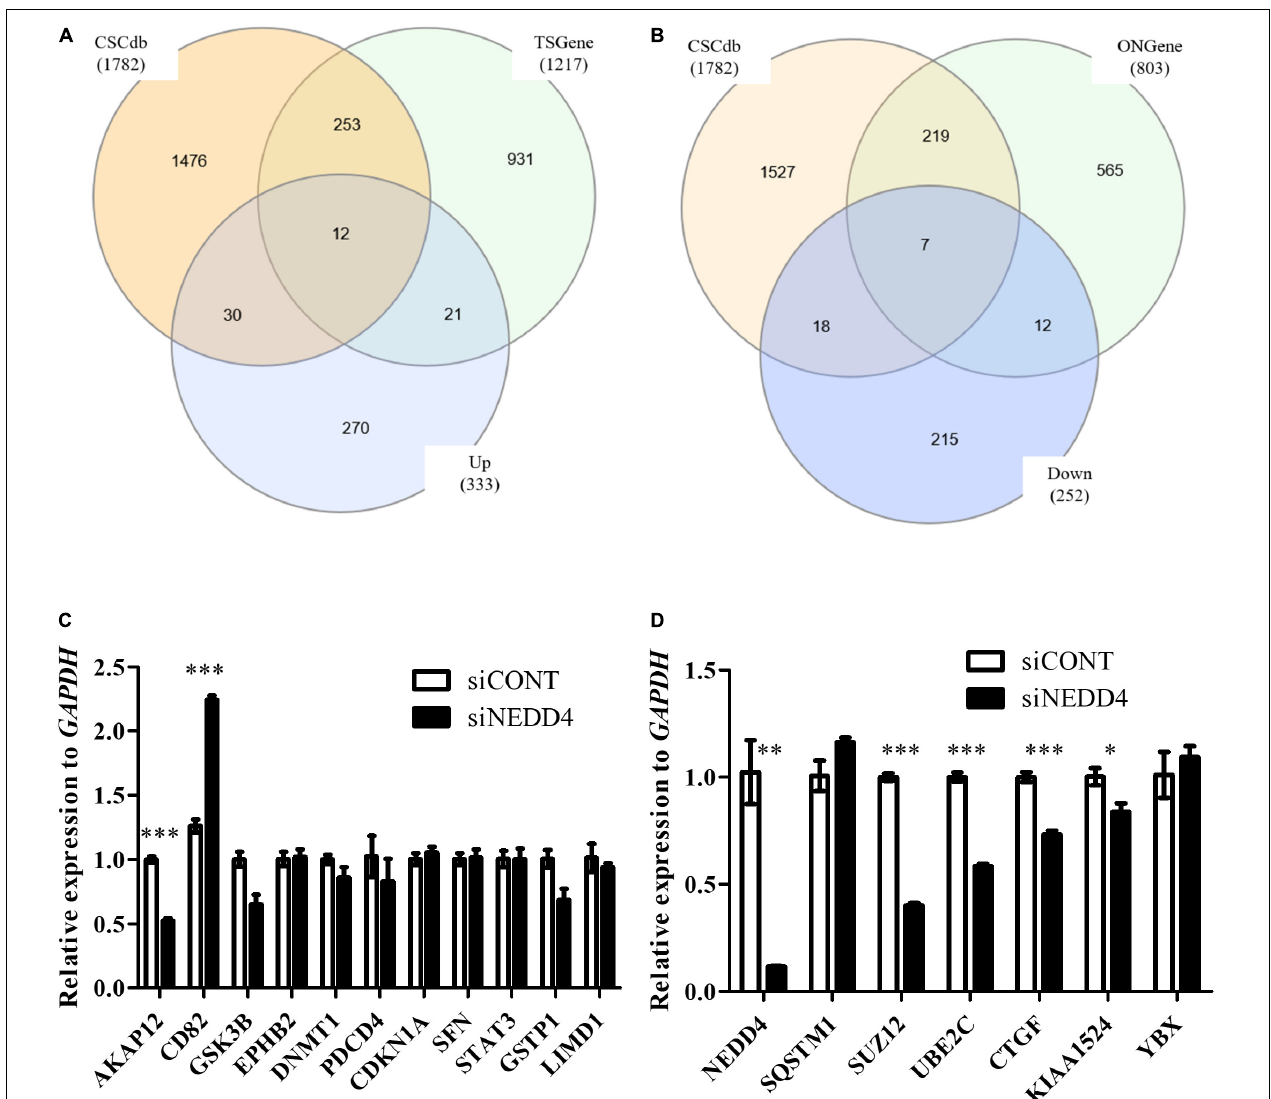
FIGURE 4 | A proteomic analysis reveals that the expression of cancer stem cell (CSC)-related proteins is altered by NEDD4 deletion. (A) Venn diagram showing the overlaps of upregulated proteins with CSC-related (CSCdb) and tumor suppressors (TSGene). (B) Venn diagram showing the overlaps of downregulated proteins with CSC-related (CSCdb) and oncogenes (ONGene). (C) The mRNA expression of CSC-related and increased proteins by NEDD4 knockdown was confirmed by qPCR in siCONT/NEDD4-treated MDA-MB-231, respectively. (D) The mRNA expression of CSC-related and decreased proteins by NEDD4 knockdown was confirmed by qPCR in siCONT/NEDD4-treated MDA-MB-231, respectively (* P < 0.05; ** P < 0.01, and *** P < 0.001).